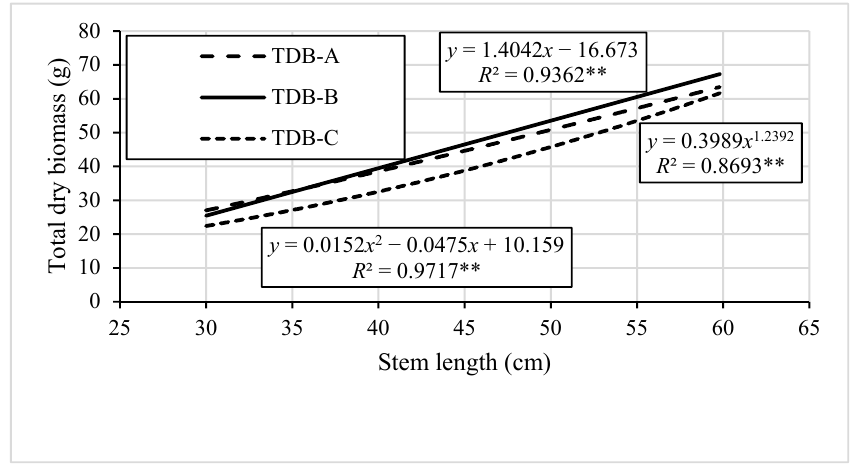
Figure 8. Relationship between stem length and total dry biomass of maple seedlings in three areas (TDB: total dry biomass; A: control area; B: Log skidded area; C: Tire track area).